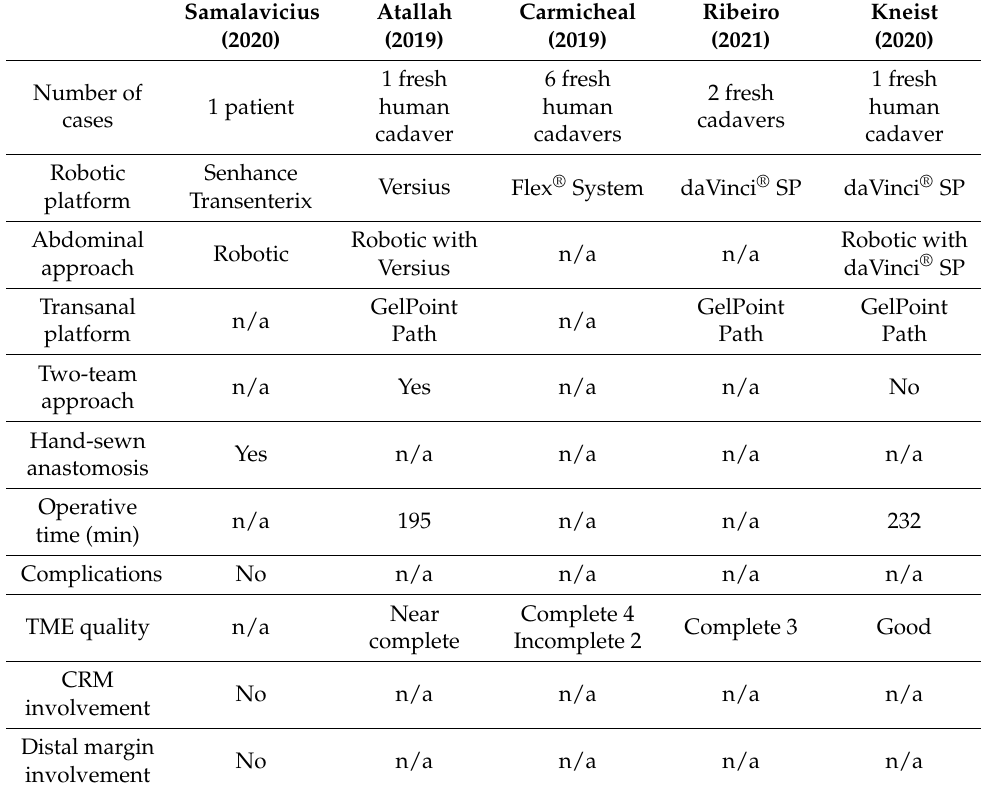
Table 2. Summary of published experience of RTaTME performed with emerging robotic